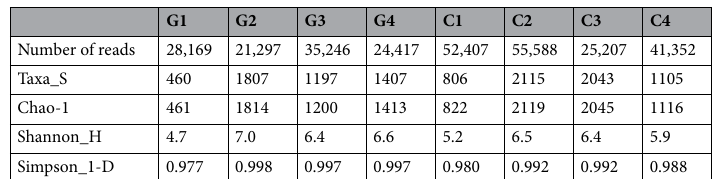
Table 1. Alpha-diversity metrics obtained for gorge (G1-G4) and cave (C1-C4) samples.